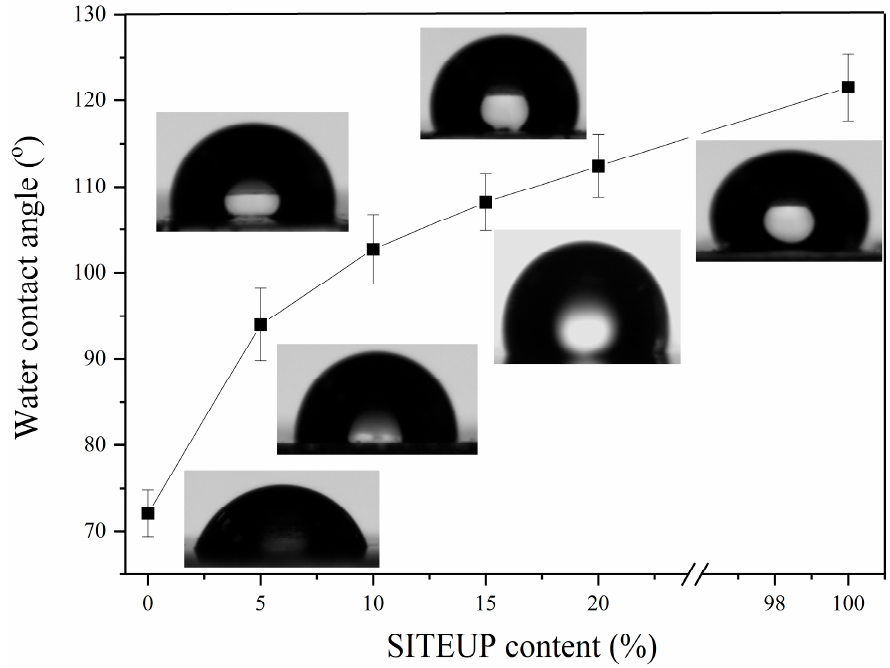
Figure 9. Water contact angles of DGEBA/IPDA thermosets with different content of